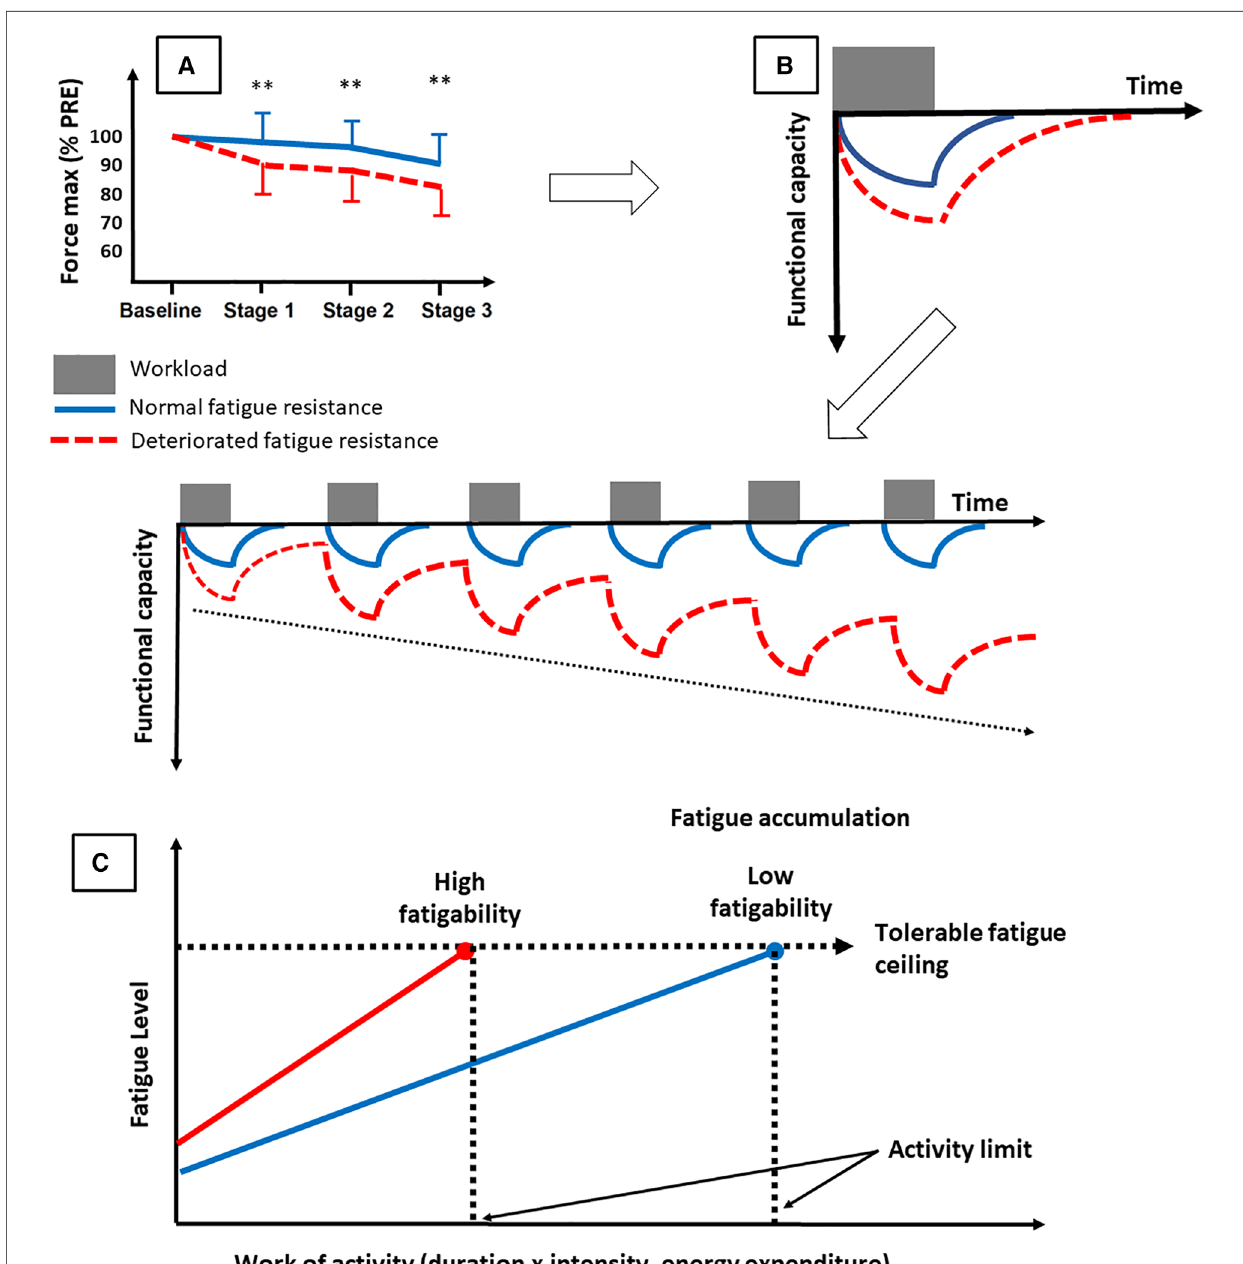
FIGURE 4 Tentative explanation of the consequences of deteriorated objective fatigability on fatigue. A deteriorated resistance to objective fatigability [ A , adapted from (29)] may lead to a greater functional decline for a given task and more time to recover from daily life activities. The tasks performed in daily life could induce an accumulation of fatigue over time ( B ) or, more likely, could lead the persons to reach their ceiling of subjective fatigue earlier in the day [ C , adapted from (97)]. This may force them to enter in the vicious circle of